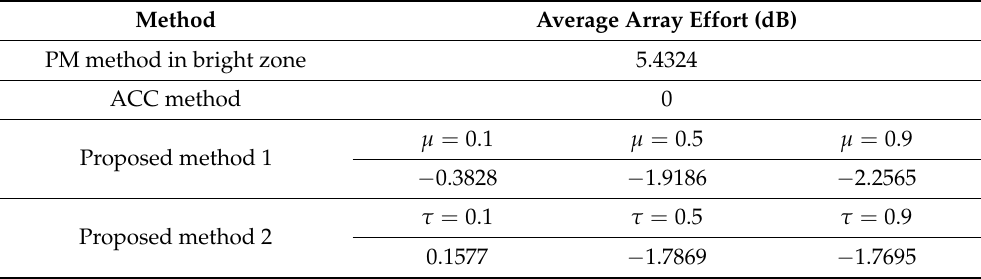
Table 8. Average array effort of different methods relative to frequency for three-dimensional